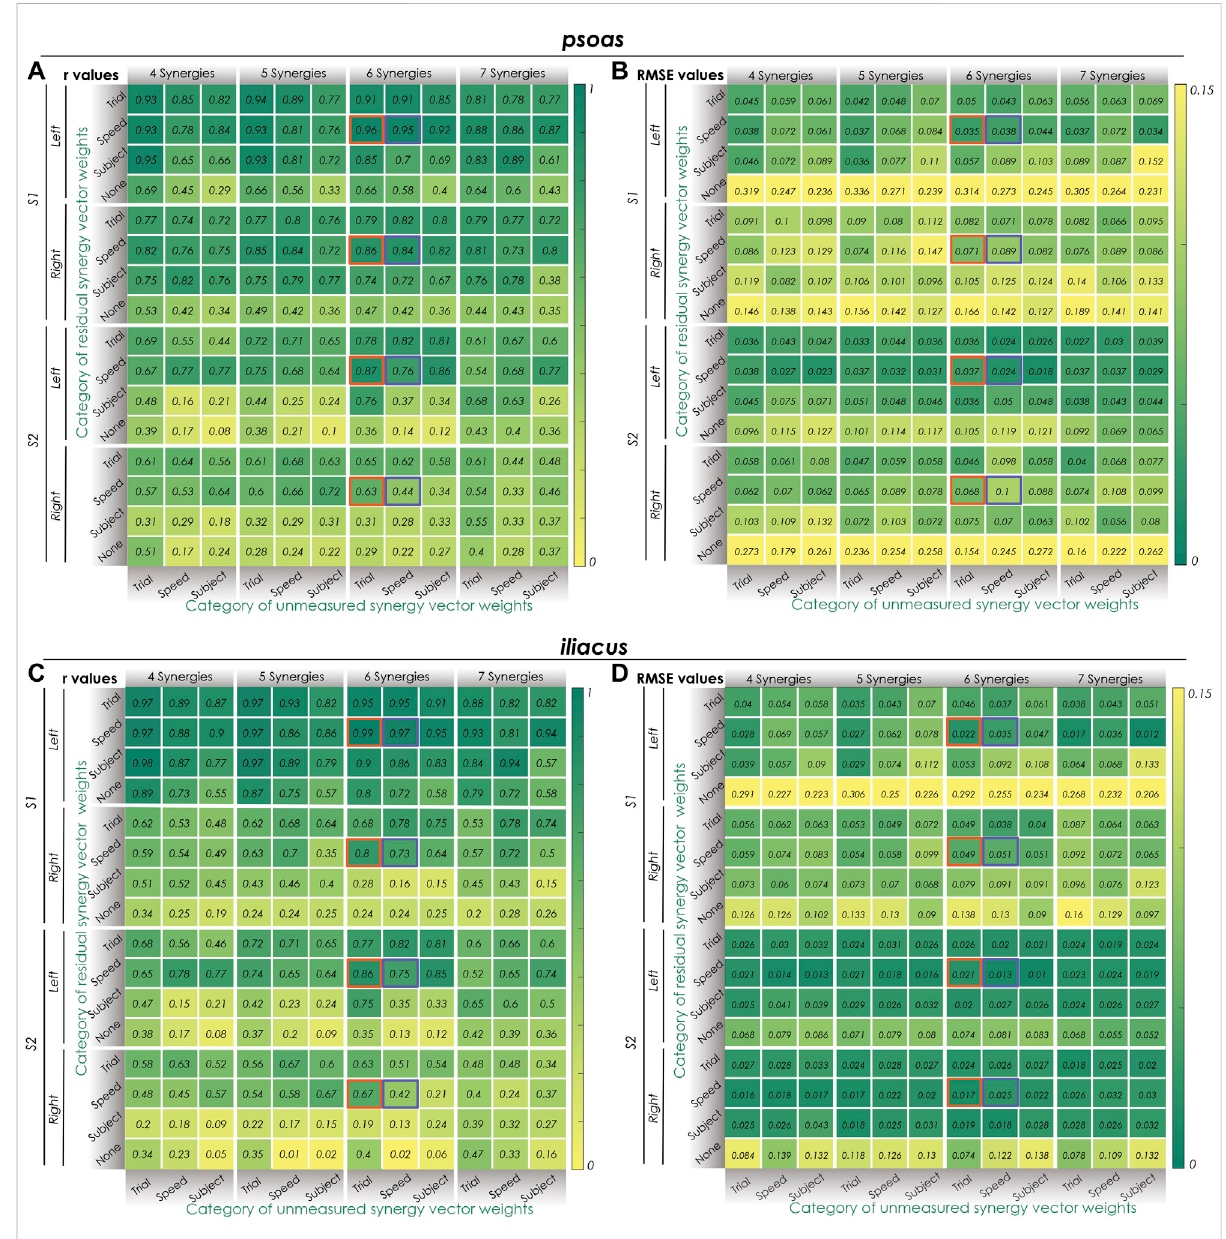
FIGURE 2 Synergy extrapolation performance for different methodological combinations when using the proposed EMG-driven calibration framework. (A) Pearson correlation coef fi cient r values and (B) root mean square error (RMSE) values for different methods of reconstructing psoas muscle activationsacrossallcalibrationtrials. (C) Pearsoncorrelationcoef fi cientrvaluesand (D) rootmeansquareerror(RMSE)valuesfordifferentmethods of reconstructing iliacus muscle activations across all calibration trials. Unmeasured (bottom) and residual (side) synergy vector weights were categorized as either trial-speci fi c, speed-speci fi c, or subject-speci fi c. Within the columns for 6 synergies, Orange boxes indicate the best